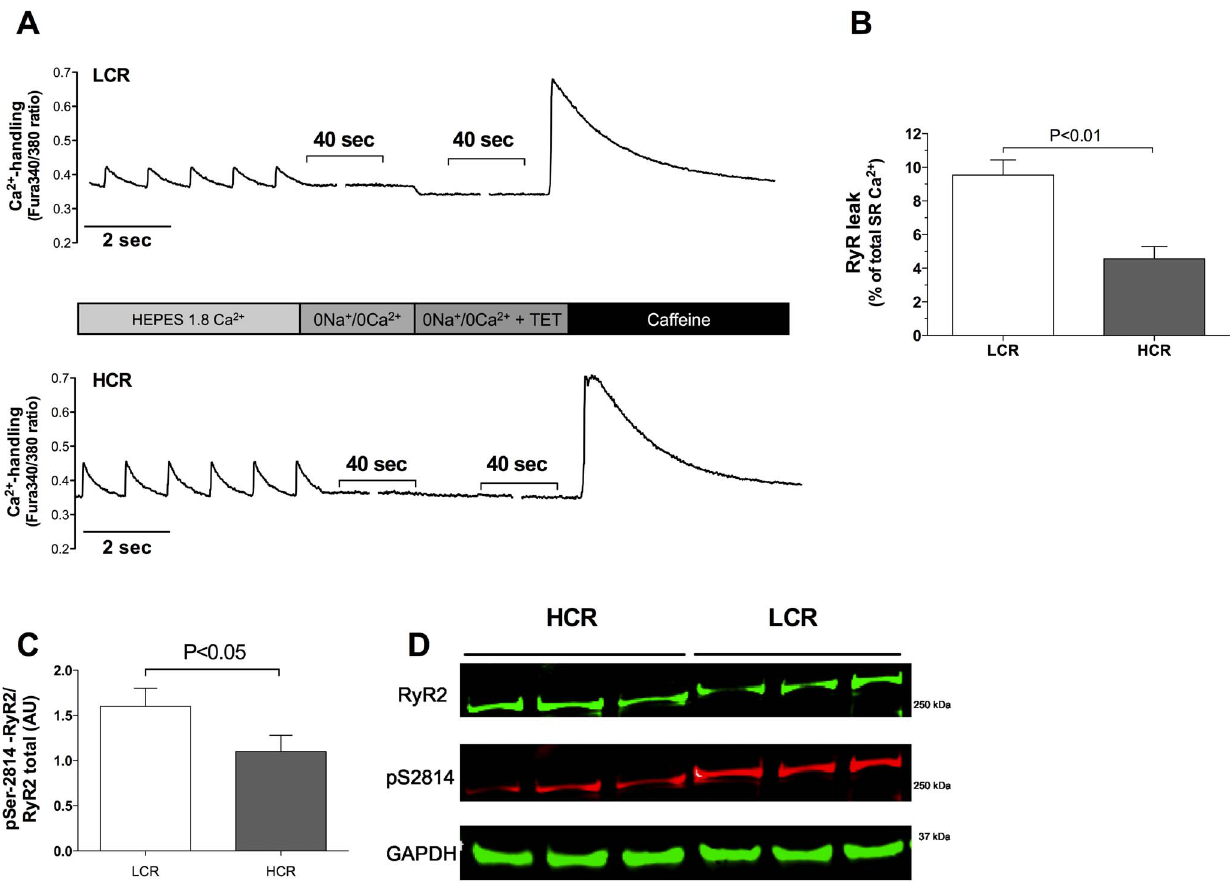
Figure 5. Recordings of diastolic sarcoplasmic reticulum (SR) Ca 2 + leak after 1 Hz electrical stimulation in normal HEPES 1.8 mM Ca 2 + solution. A, Exemplary recordings show the protocol of quantification of SR Ca 2 + -leak by determination of diastolic Ca 2 + -levels in quiescent atrial cells with 0 Na + /0 Ca 2 + in the external perfusion solution compared to perfusion solution with 0 Na + /0 Ca 2 + + Tetracaine (TET) that inhibits the opening of the ryanodine receptor (RyR2). Recordings were followed by Caffeine (10 mM) induced Ca 2 + depletion of the SR to determine SR Ca 2 + storage B, Diastolic SR Ca 2 + -leak was significantly increased in Low Capacity Runner (LCR) rats compared to High Capacity Runner (HCR) rats. n=5 animals, n=4 2 6 cells from each animal. C, Western blot analyses of the ratio between phosphorylated Serine-2814/RyR2 display a significant higher expression in LCR rats (n=4) compared to HCR rats (n=3). D, Representative Western blots. Data are presented as mean 6 SD.